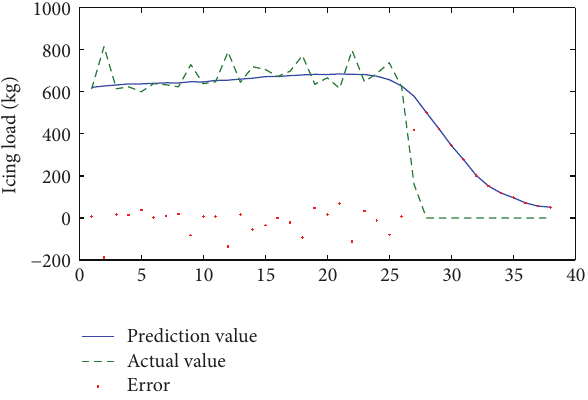
Figure 5: Results of prediction in the same icing process ( 𝑘 = 1 ) for the first serious icing process (2009.12.17–2009.12.20).